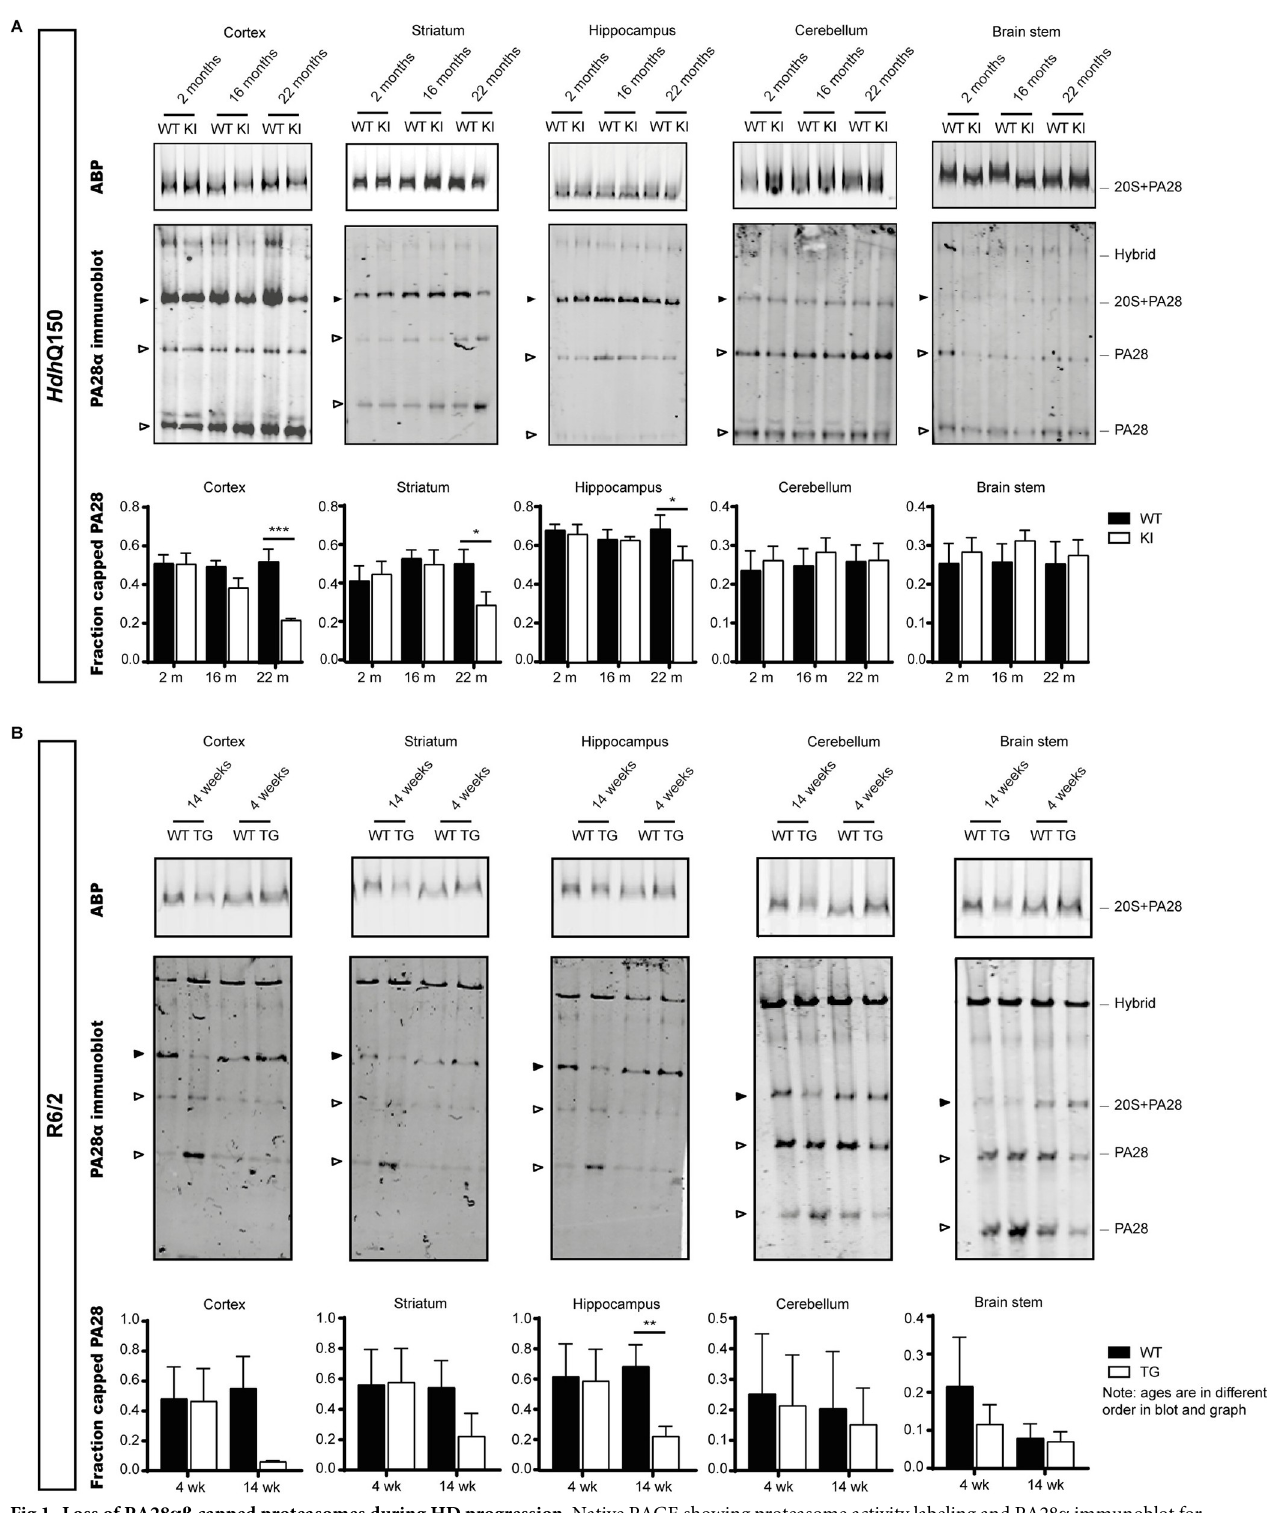
Fig 1. Loss of PA28 αβ capped proteasomes during HD progression. Native PAGE showing proteasome activity labeling and PA28 α immunoblot for different brain regions of Hdh Q150 (A) and R6/2 (B) during disease progression. The upper blots depict fluorescent ABP signal, only showing the bands representing PA28 capped proteasomes. The graphs in the lower panels show quantification of the fraction of capped PA28 αβ (PA28 α bound to 20S, black arrowheads, divided by the total pool of PA28 α (black and open arrowheads). Data are shown as mean ± SEM ( Hdh Q150 n = 3/4; R6/2 n = 3/4). A one sample